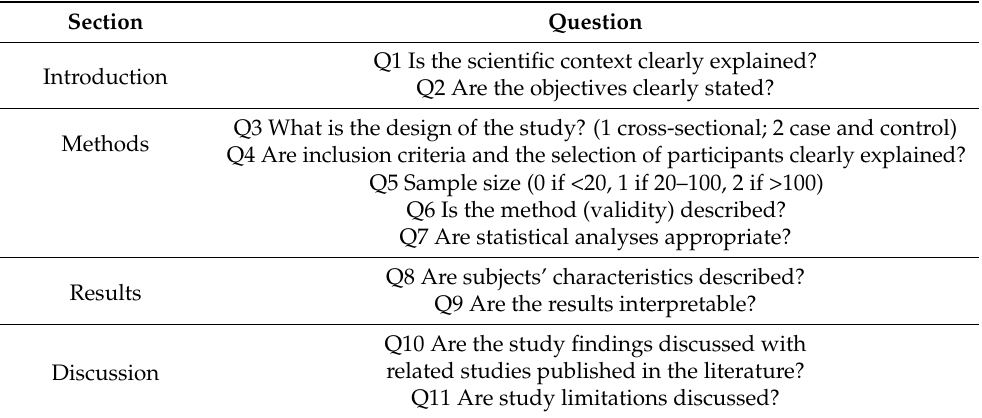
Table 1. Quality analysis form used in the scoping review for observational